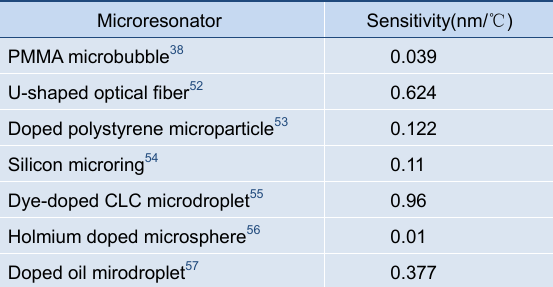
Table 1 | Sensitivities of temperature sensors based on WGM microresonator .